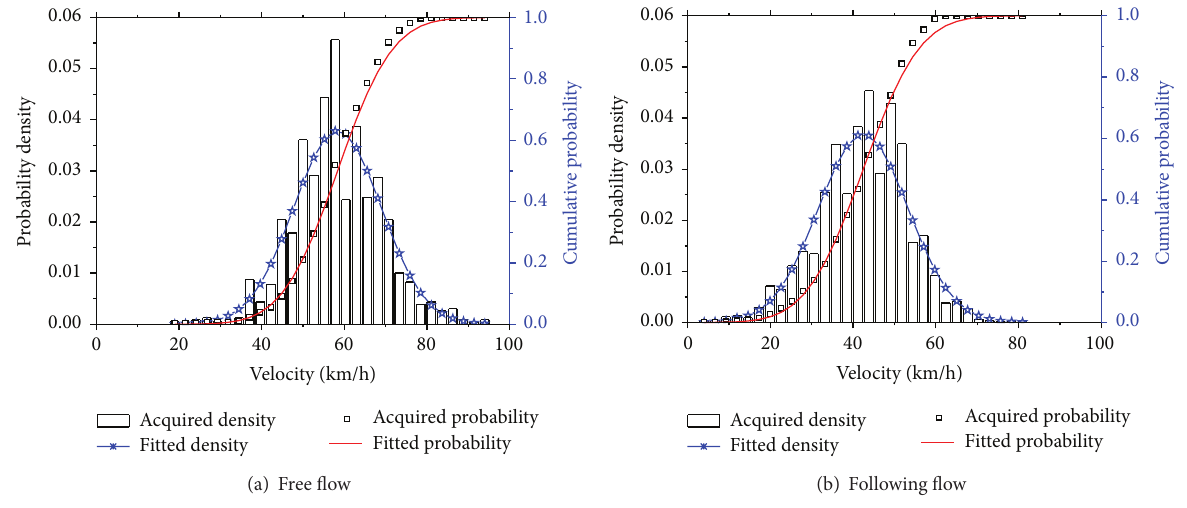
Figure 8: Probability distributions for speed with different flow states.